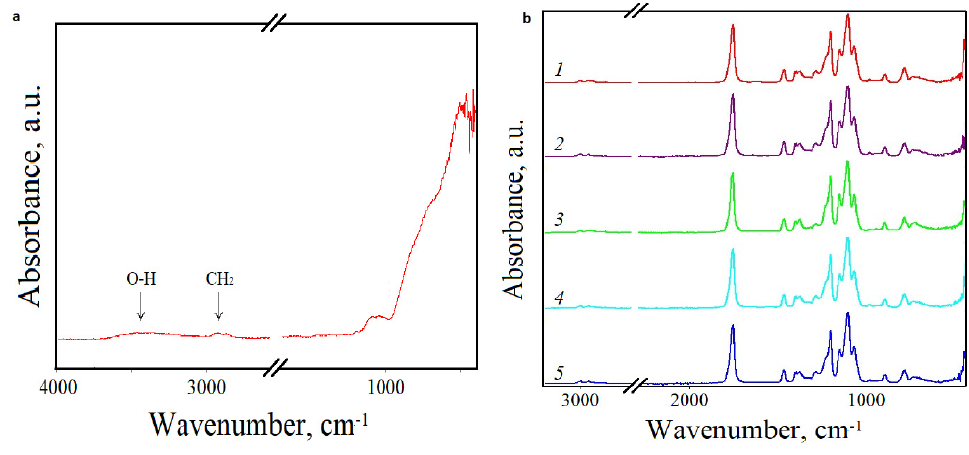
Figure 2. IR spectra of AONF ( a ), PLA (1) and PLA/AONF ( b ) composite films with AONF inclusion 0.1% (2), 0.2% (3), 0.5% (4) and 1% (5).